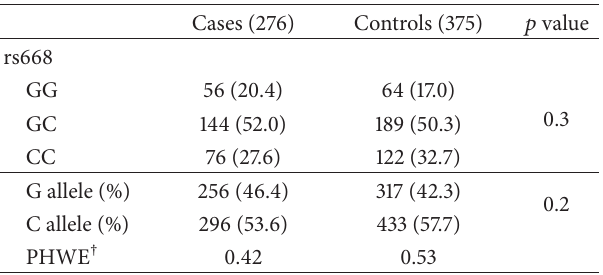
Table 2: Distribution of rs668 polymorphism genotypes and alleles in patients with diabetic nephropathy (cases) and in those without diabetic nephropathy